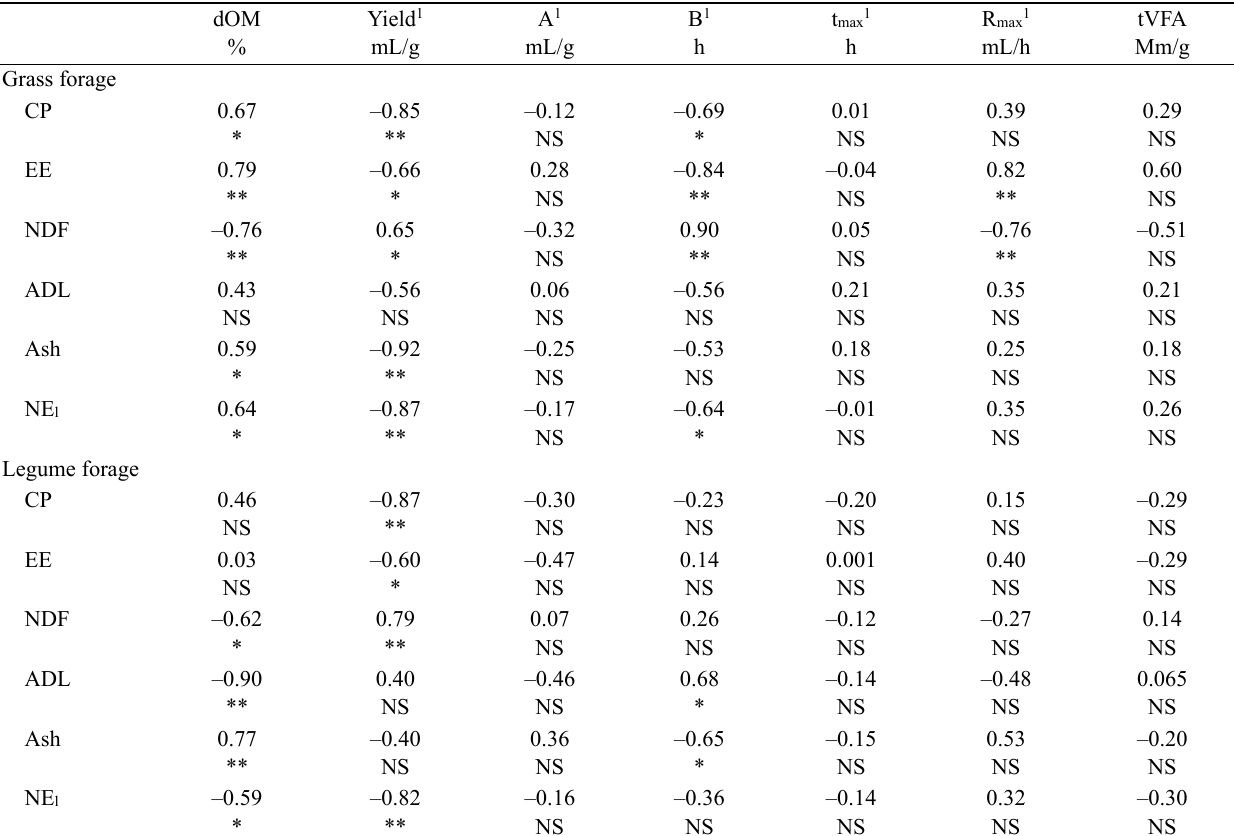
Table 7. Significance of correlation between some chemical parameters and in vitro fermentation data for grass and legume